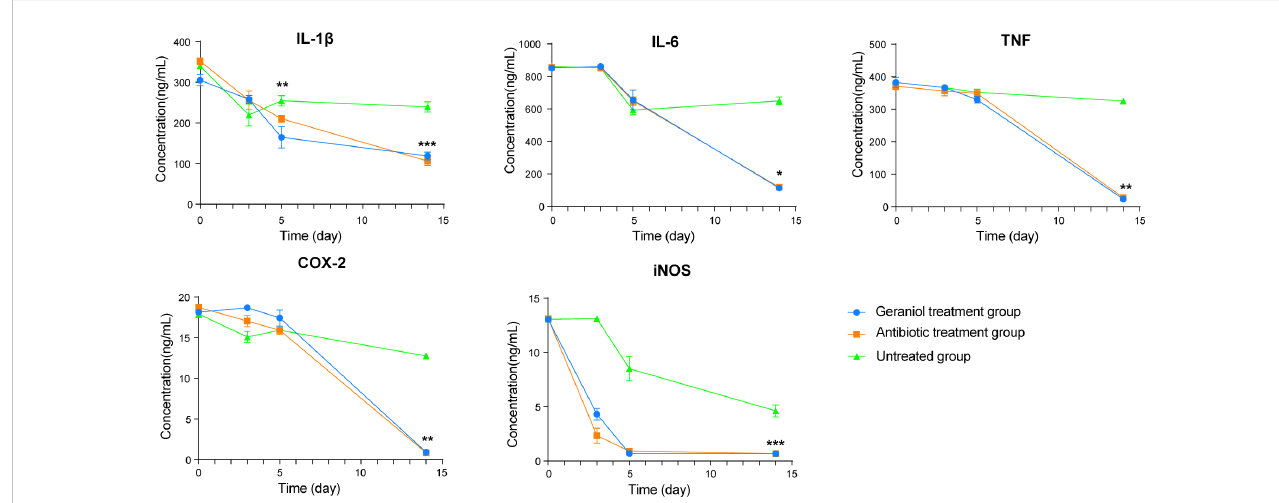
FIGURE 4 Dynamic changes of serum in fl ammatory factors in dairy cows with mastitis treated with antibiotics and geraniol. (A) Nterleukin-6; (B) Interleukin-1 b ; (C) Tumor necrosis factor- a ; (D) Cyclooxygenase-2 and (E) Inducible nitric oxide synthase. (p values (compare with day 0) calculated by Mann – Whitney U: ∗ < 0.05, ∗∗ < 0.01, and ∗∗∗ <